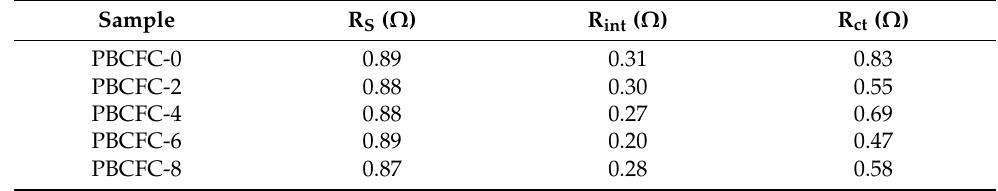
Table 1. The equivalent circuit components produced by the EIS values of PBCFC-x (x = 0, 2, 4, 6, 8). Sample